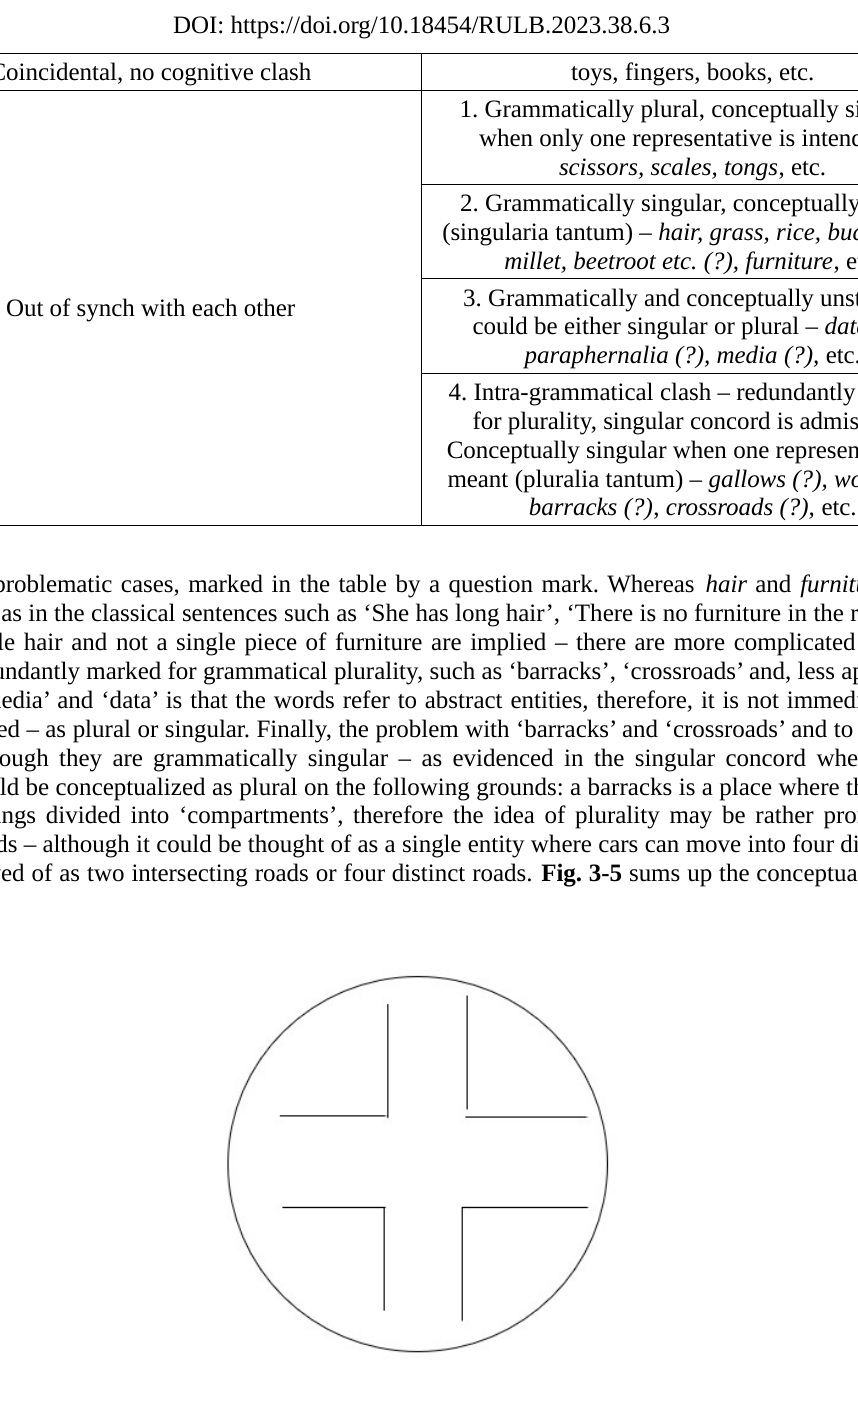
Figure 3 - Crossroads as a single